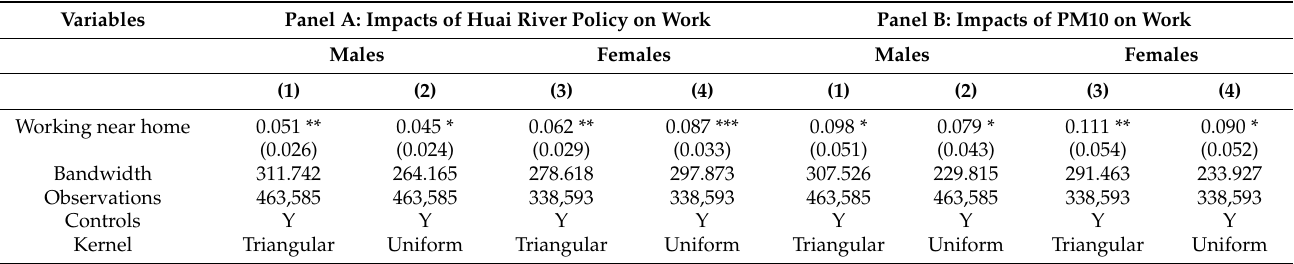
Table 4. The impacts of PM 10 on work by